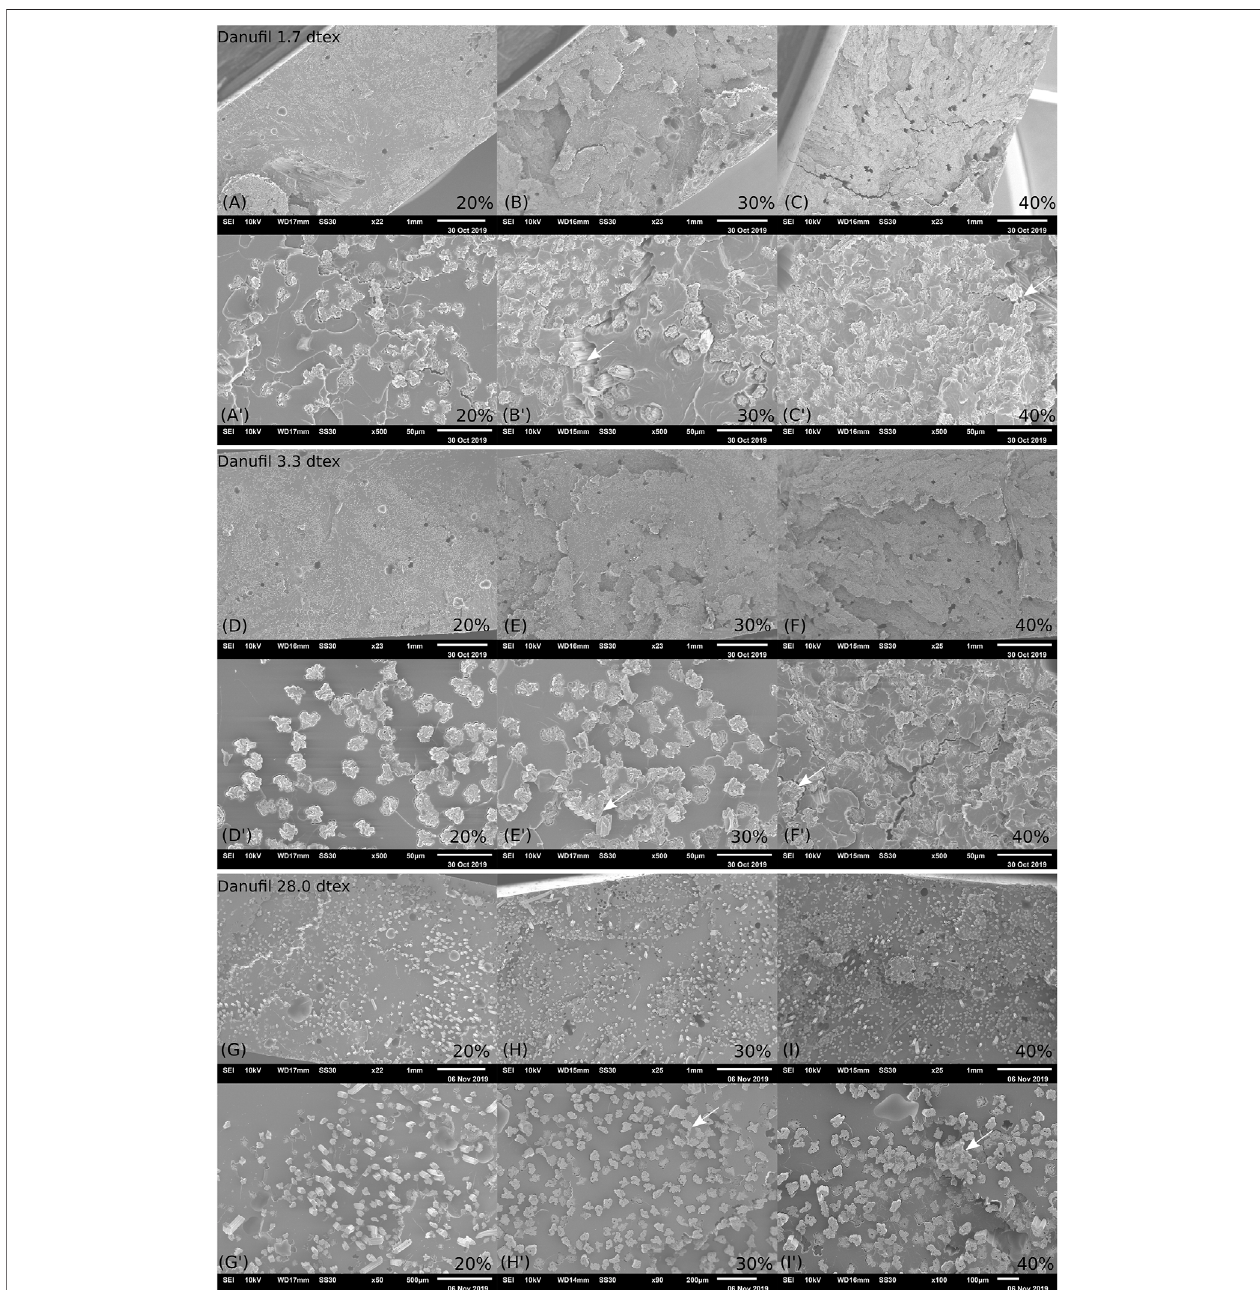
FIGURE 6 | SEM micrographs of composites reinforced with different fi ne Danu fi l fi bres and fi bre mass fractions: (A – C) Danu fi l 1.7 dtex, (D – F) Danu fi l 3.3 dtex, (G – I) Danu fi l 28.0 dtex). A few places where whole fi bre collectives were pulled out are marked with an arrow.